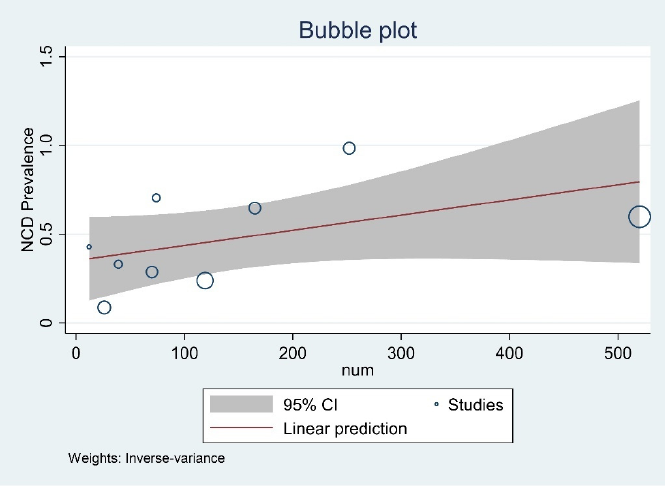
Figure 3. Bubble plot with 95% Confidence interval of pooled prevalence of NCDs among prisoners of India.